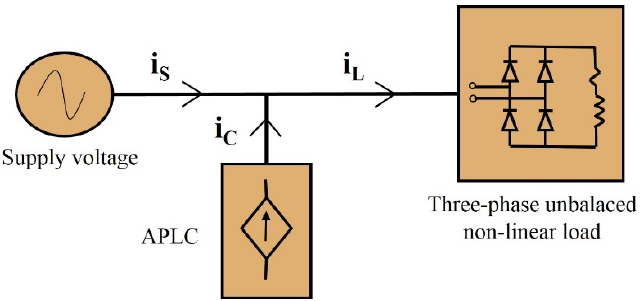
Figure 8. Scheme of an unbalanced non-sinusoidal compensated three-phase system. A three-phase unbalanced voltage set with distortion is applied to the load; Table 4. Figure 9 shows the supply voltage waveforms.